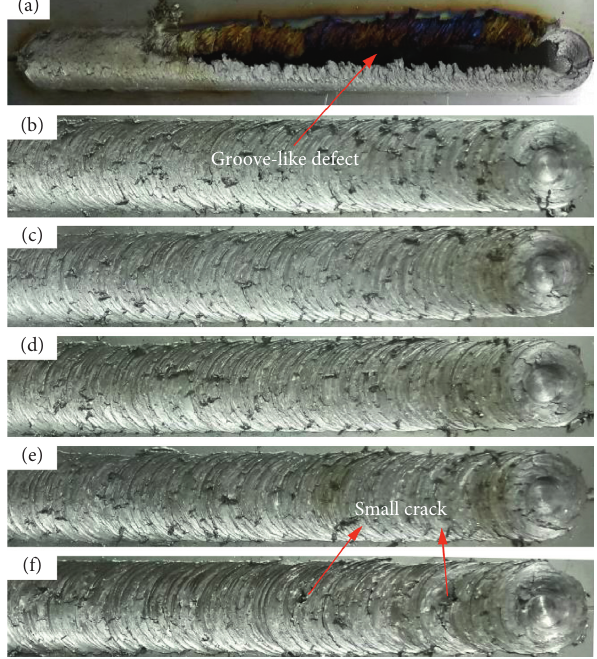
Figure 4: Macrographs of top surface of FSW joints weld at various rotation speeds: (a) 600rpm, (b) 500rpm, (c) 450rpm, (d) 400rpm, (e) 350rpm, and (f)